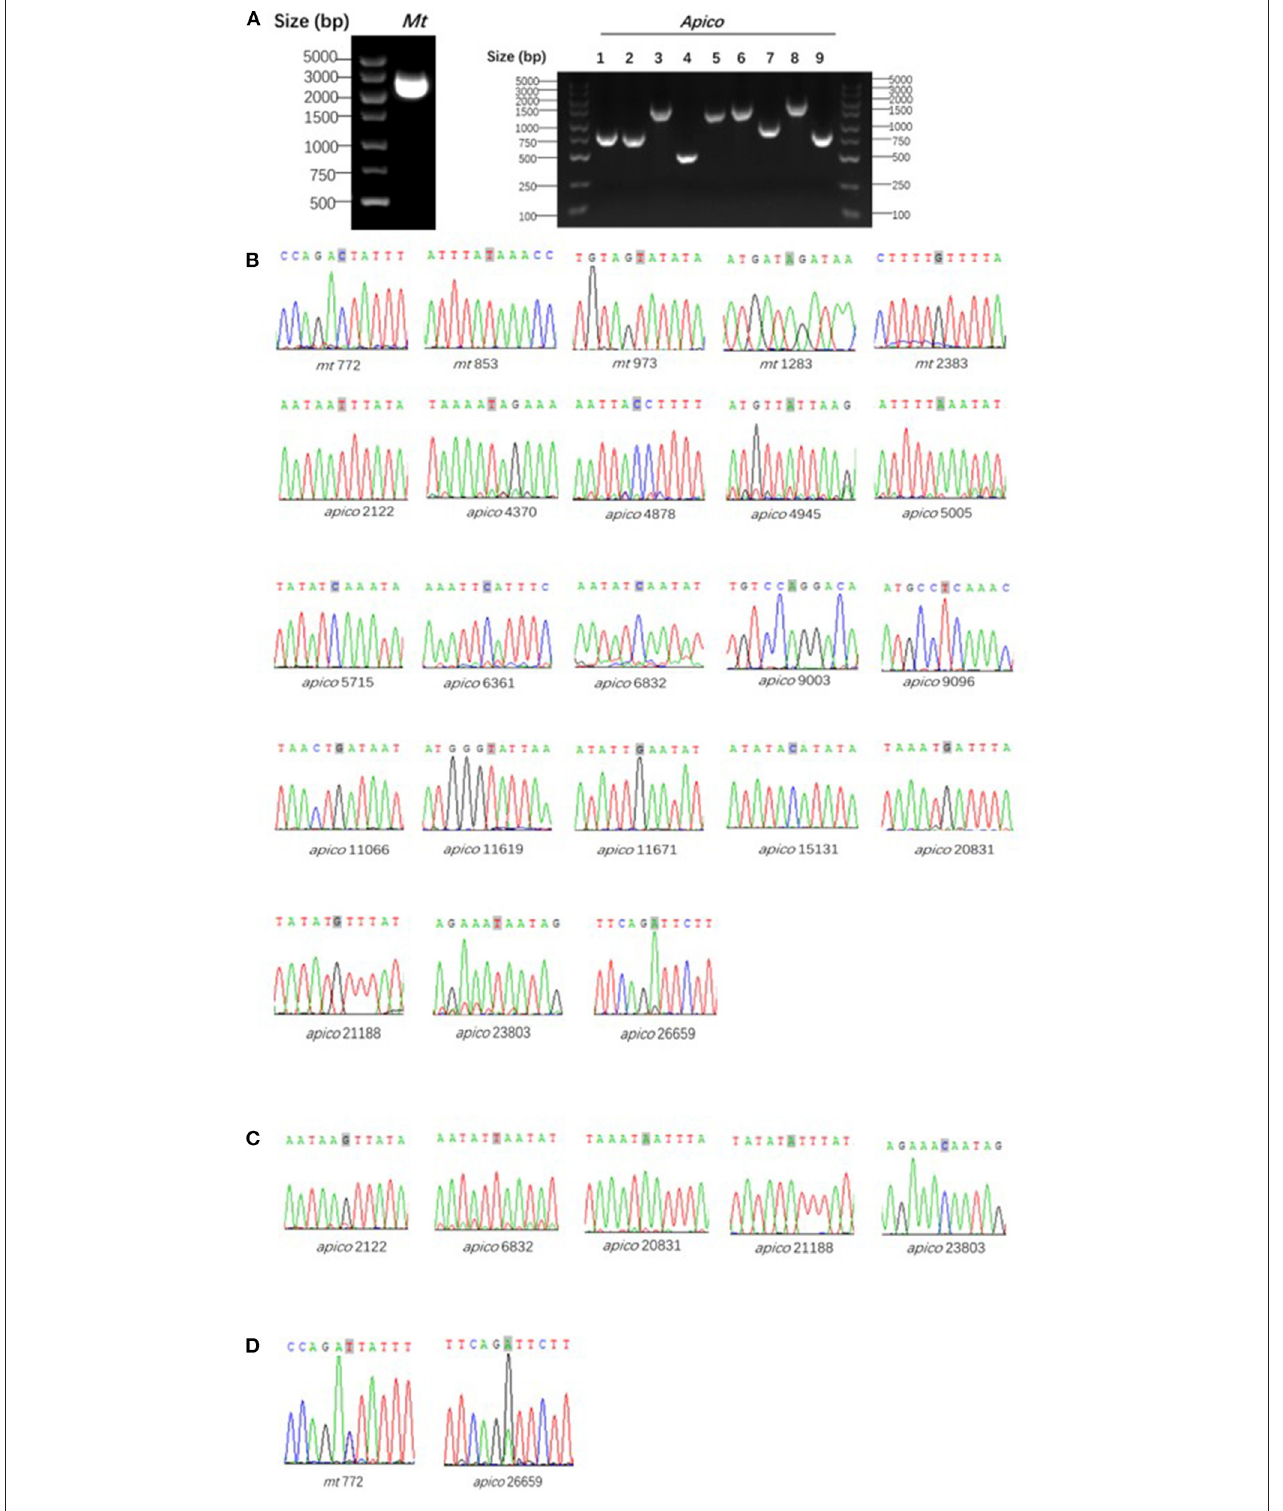
FIGURE 3 | Agarose gel electrophoresis of polymerase chain reaction (A) and sequencing wave of the target loci with wild-type (B) , mutant type (C) , and mixed type (D) compared to the reference Plasmodium falciparum 3D7. Gray shading marked in the sequencing waves indicates the target loci.